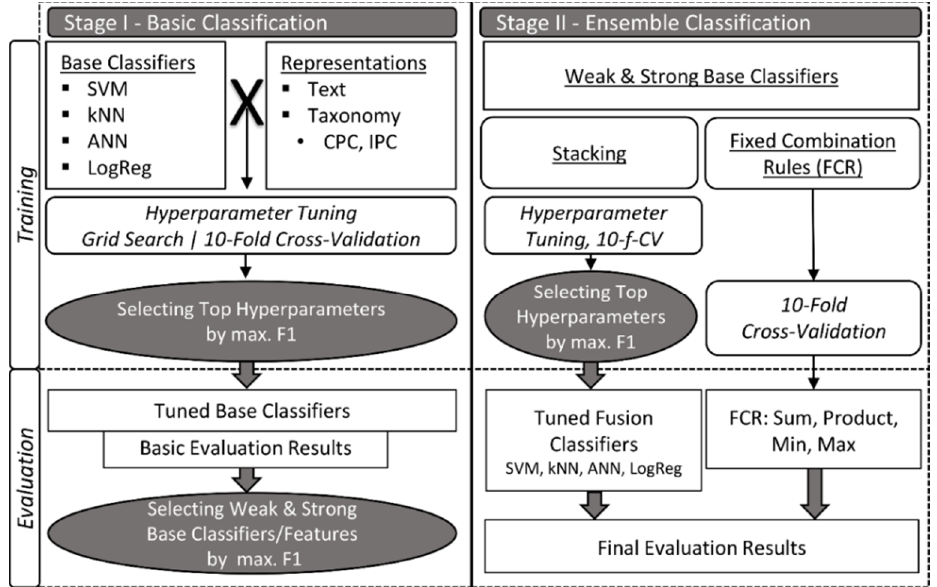
Figure 2. Overview of the main stages of data processing and evaluation. SVM—Support Vector Machine, ANN—Artificial Neural Network, kNN—k-Nearest-Neighbor, LogReg—Logistic Re- gression.